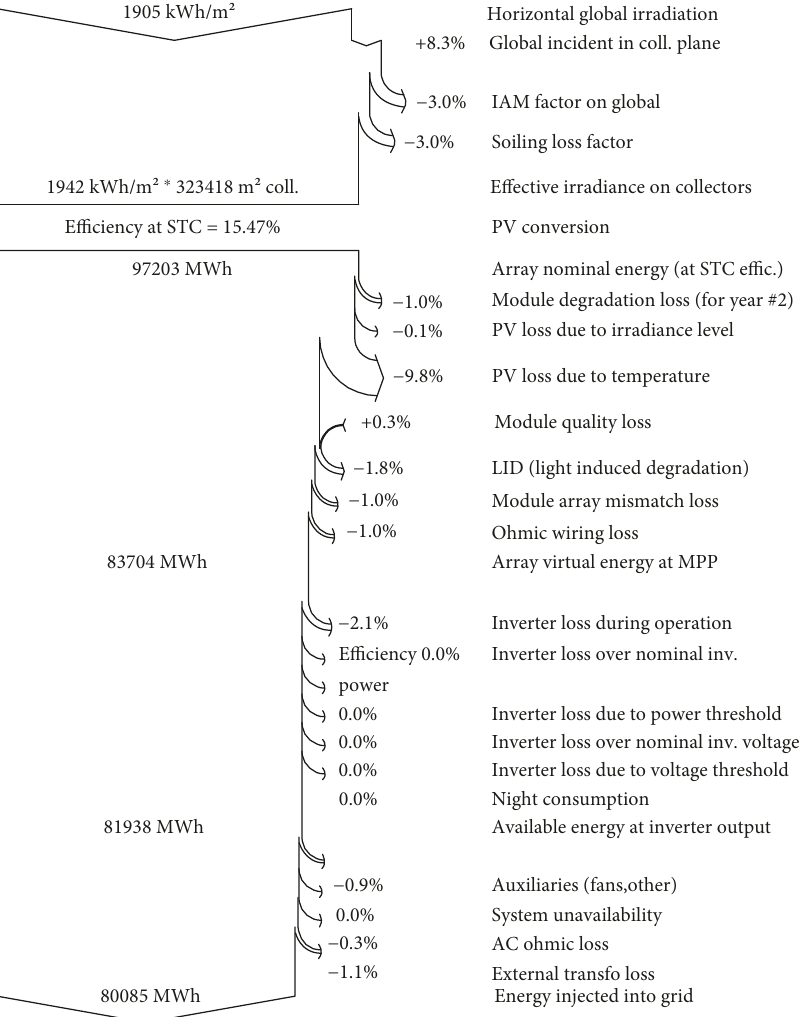
Figure 4: Simulation results of losses over the whole year at the PV